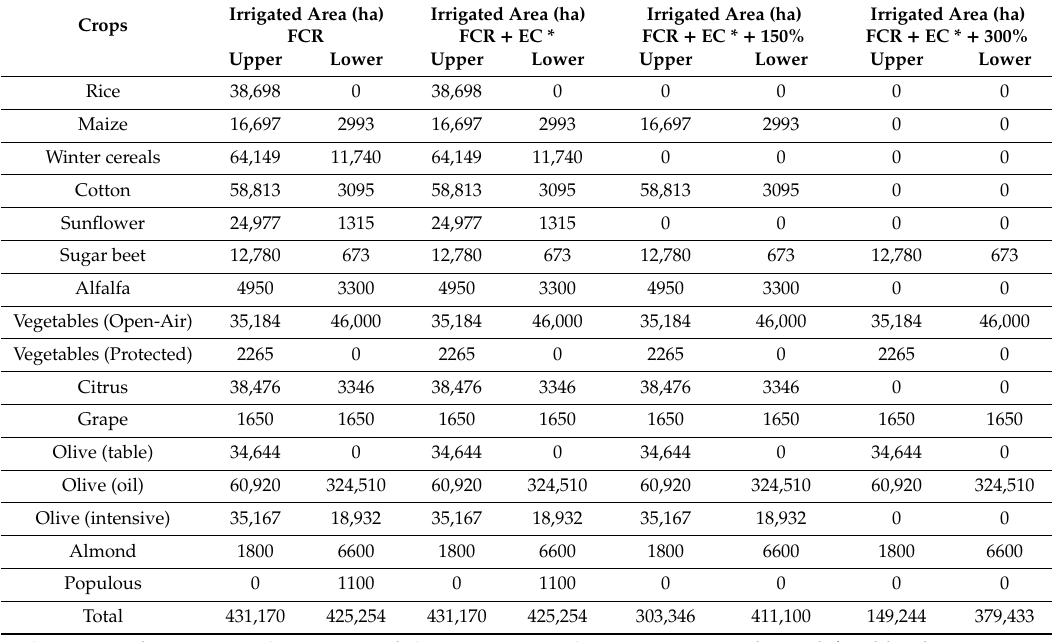
Table 5. Irrigated area per crop in the scenarios of water